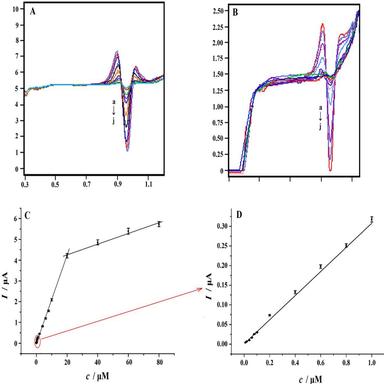
The curves of SDLSV of different concentration Trp in 0.02 M H3PO4 solution obtained at the Ni NPs/N-C/CPE after accumulation at 0.3 V for 90 s. (A) a-j: 1.0, 2.0, 4.0, 6.0, 8.0, 10, 20, 40, 60, 80 μM; (B) a-j: 0.01, 0.02, 0.04, 0.06, 0.08, 0.1, 0.2, 0.4, 0.6, 0.8 μM at a scan rate of 0.1 V s − 1 . (C) The linear relationship between the Ip and Trp concentration in range of 0.01–80 μM. (D) Calibration curve for Trp in low concentration range (0.01–1.0 μM).